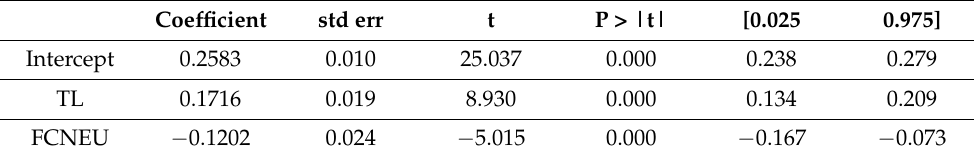
Table 5. Results of the second stage of modeling.